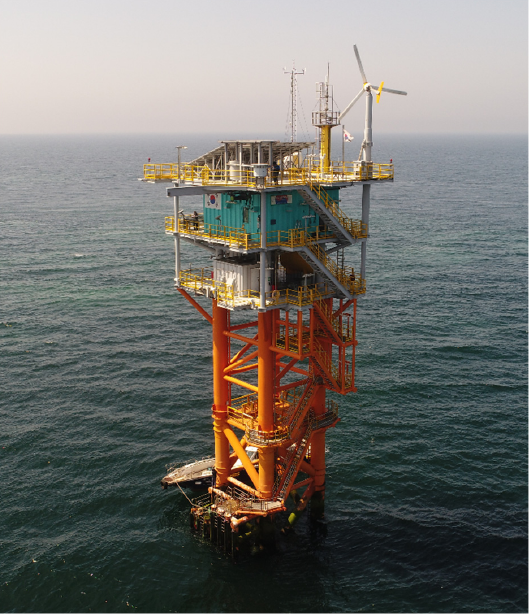
Figure 4. Gageocho ORS [14].